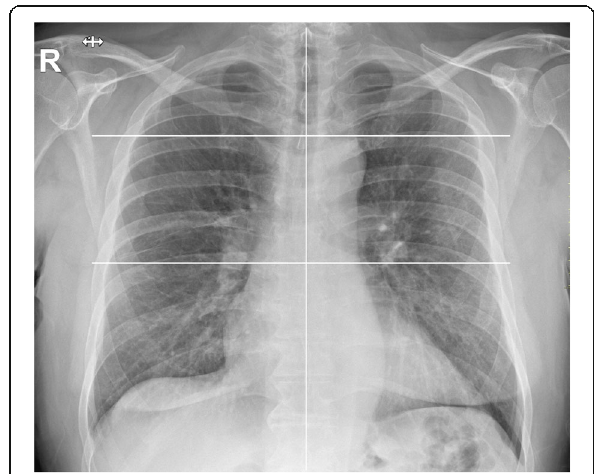
Fig. 1 CXR subdivision, with three parts for each lung: superior zone (from the lung apex to the aortic arch profile), middle zone (lung hilum, from the aortic arch profile to the inferior margin of the left pulmonary hilum), and inferior zone (from the inferior margin of the left pulmonary hilum to the diaphragm)